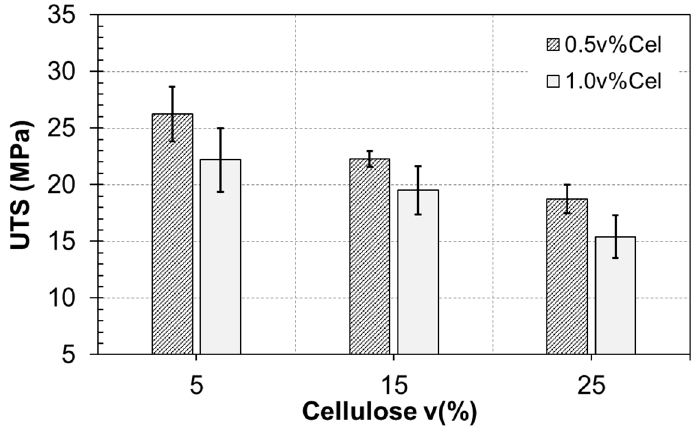
Figure 3. Ultimate tensile strength of bio-composites made of 1.5 v% chitosan/(0.5 v% and.1.0 v%) cellulose and 1.25 v% of acetic acid.